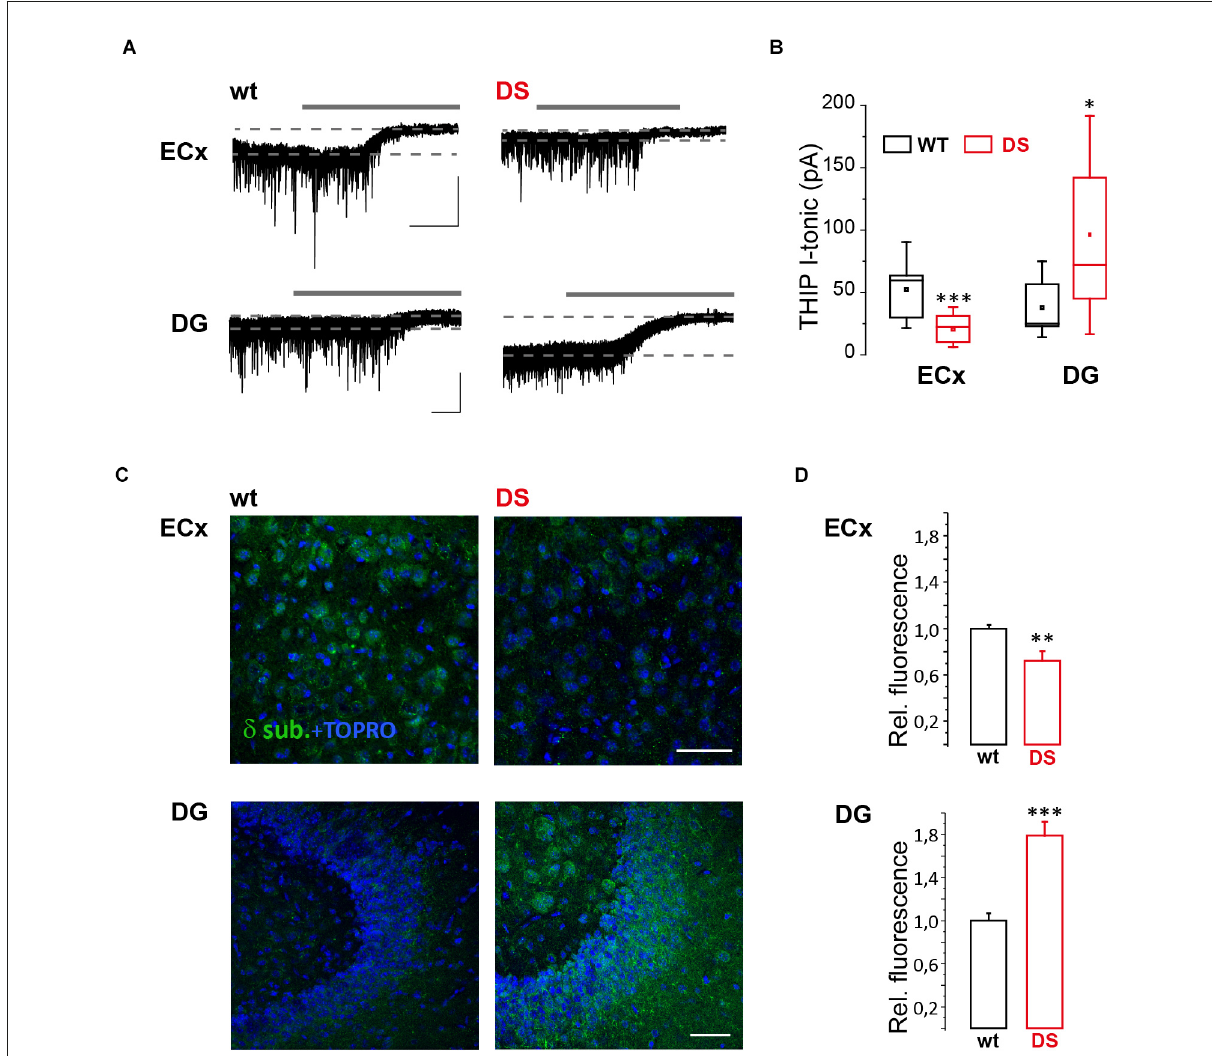
FIGURE2 GABA A R δ subunit response and expression are altered in DS mice. (A) Whole-cell recordings showing representative tonic currents (I-tonic) evoked by THIP (not indicated) and evaluated with GABA A receptor antagonist bicuculline (gray continuous lines; see “Materials and methods” Section) in layer V pyramidal neuron of brain slices containing ECx and DG from 15 to 19 days old DS mice (Na v 1.1 +/- ) and same age littermate wild type (wt) controls. Scale bars, 30 s, 50 pA. (B) Box chart summarizing I-tonic in DS and wt mice from ECx ( n = 10 cells from four mice for wt and 10 cells from three mice for DS mice, p = 6.783 E − 4 , two sample t -test) and DG ( n = 9 cells from five mice for wt and nine cells from five mice for DS mice, p = 0.017, two sample t -test). (C) Confocal fluorescence images of δ subunit expression in ECx and DG from 19 to 21 days old DS mice and same age littermate wt controls. (D) Histogram summarizing the relative fluorescence in DS compared to wt mice from ECx (26 and 29 fields from three wt and three DS mice, respectively, p = 0.003, two sample t test) and DG (27 and 38 fields from 4 wt and 4 DS mice, respectively, p = 0.00001, two sample t -test). ∗ p ≤ 0.05, ∗∗ p ≤ 0.01, ∗∗∗ p ≤